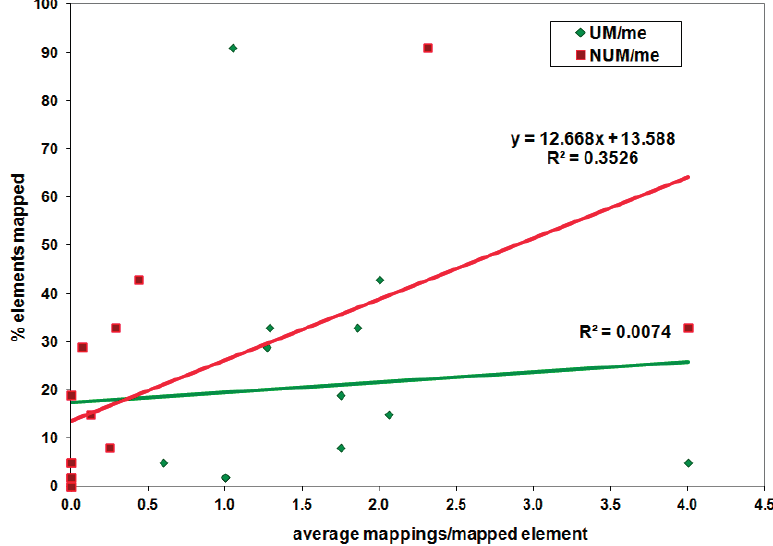
Figure 5. Correlation of mappings per element (both unique and non-unique) to the percentage of total elements mapped in the